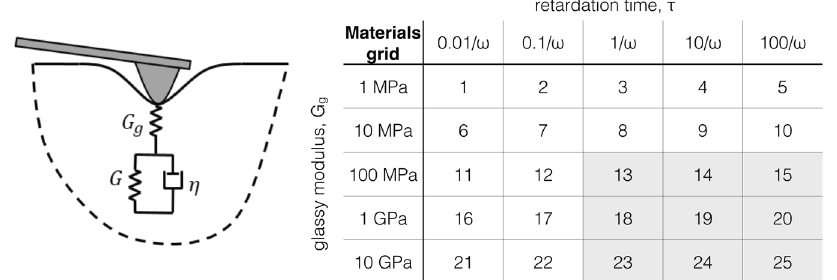
Figure 1. Schematic of a parabolic AFM tip penetrating a linear viscoelastic sample modeled with the standard linear solid (SLS). The geometry of the tip introduces non-linearities in the relationship between force and indentation which are very typical in AFM operation. These non-linearities are evidenced in Eq. (7) described by Lee and Radok formulation 32 which is only appropriate for the loading portion (i.e., monotonic increase of tip-sample contact radius). In this study we have aligned to the more general Ting’s theory 24 which has no restriction in the indentation history (more information in the Methods section). The table next to the model shows the material grid used in the simulations, where 5 values of glassy moduli ( G g ) where chosen along with 5 different retardation times ( τ ). Each value of retardation time is given in terms of the 1st eigenmode resonance frequency ( ω ). Each value of glassy modulus was combined with each of the values of retardation times, to make a total of 25 material